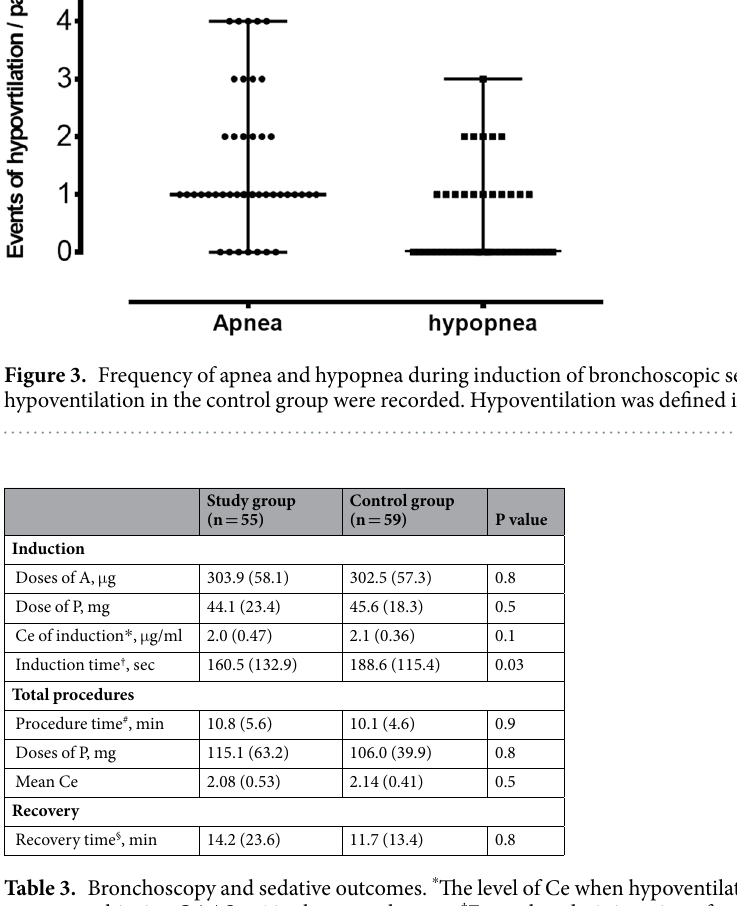
Table 3. Bronchoscopy and sedative outcomes. * The level of Ce when hypoventilation occurs in the study group or achieving OAAS < 4 in the control group. † From the administration of propofol to the time point of induction Ce. # From the time of bronchoscope insertion to the time of removal. § Duration between complete bronchoscopy and regain